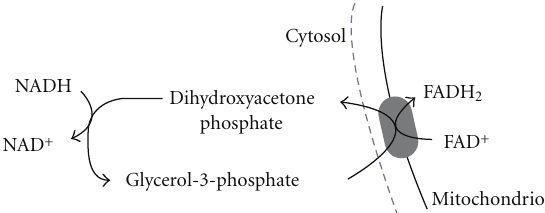
Figure 15: Glycerol-3-phosphate shuttle. The reduction of FAD + within the mitochondria occurs within the TCA cycle, where the enzyme glycerol-3-phosphate dehydrogenase is linked within succinate dehydrogenase (TCA cycle) within complex II of the electron transport